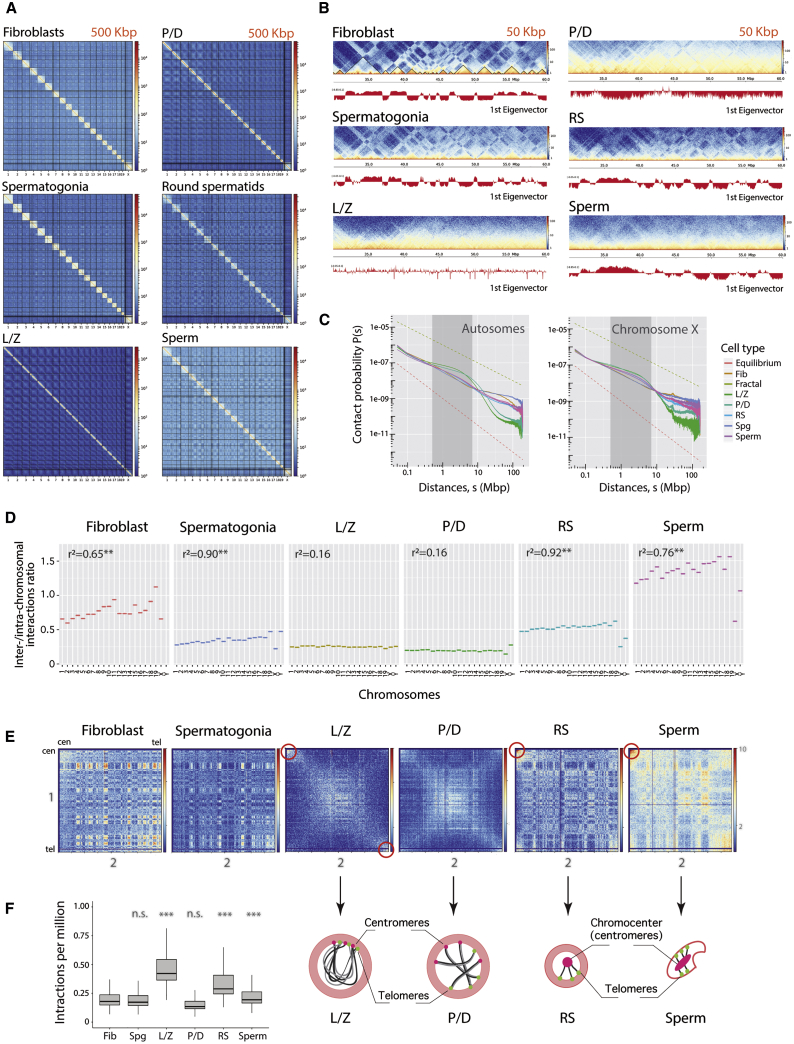
Chromosomal Organization in Interphase, Pre-meiotic, Meiotic, and Post-meiotic Cells(A) Genome-wide ICE-corrected heatmaps at 500 kbp for the cell types analyzed.(B) Chromosome 18 region-specific ICE-corrected heatmaps at 50 kbp (from 20 Mbp to 60 Mbp), depicting compartment signal (first eigenvector) for all cell types.(C) Contact probability P(s) as a function of genomic distance in all cell types for autosomes (left panel) and the X chromosome (right panel). Discontinuous straight lines correspond to the fractal (green) and equilibrium (red) models (Lieberman-Aiden et al., 2009). Gray-shadowed area expands the genomic region from 0.5 to 7 Mbp.(D) Inter- and intra-chromosomal interaction ratios for each chromosome and cell type. Correlation values (∗∗p < 0.001) between the inter- and intra-chromosomal ratio and chromosomal size (autosomes only) are shown for each cell type.(E) Heatmaps showing normalized inter-chromosomal interactions between chromosomes 1 and 2 in all cell types. Red circles represent high-contact regions.(F) Left panel: boxplots depicting inter-chromosomal interactions per million at sub-centromeric regions (from the centromere up to 3.5 Mbp) for all cell types (Wilcoxon test, ∗∗∗∗ < 0.0001; n.s., not statistically significant when compared to fibroblasts). Right panel: schematic representation of chromosomes and centromeres and telomeres in L/Z, P/D, RSs, and sperm. Dots represent centromeres (pink) and telomeres (green). In RSs and sperm, all centromeres associate in the center of the cell forming the chromocenter.Fib, fibroblast; Spg, spermatogonia; L/Z, leptonema-zygonema; P/D, pachynema-diplonema; RS, round spermatids; cen, centromeres of acrocentric chromosomes; tel, telomeres of non-centromeric ends. See also Figures S2–S5.